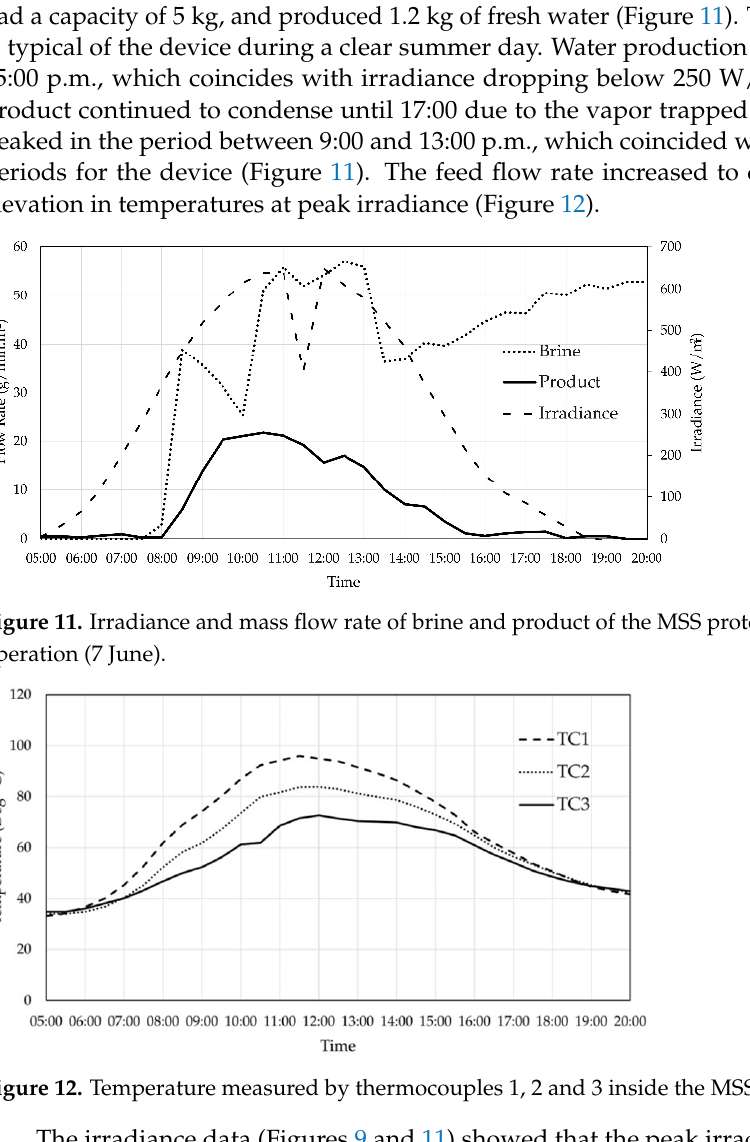
Figure 10. Temperature measured by thermocouples 1, 2 and 3 inside the MSS prototype ‐ 1 (Apr